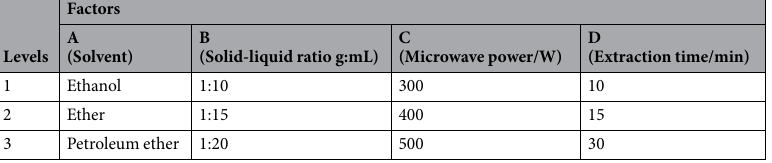
Table 1. The four factors with three levels for orthogonal test.